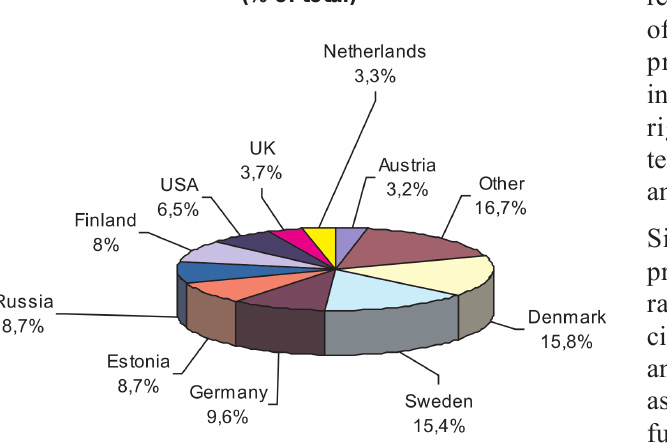
Table 1. FDI by sectors October 1, 2004 (Lithuanian